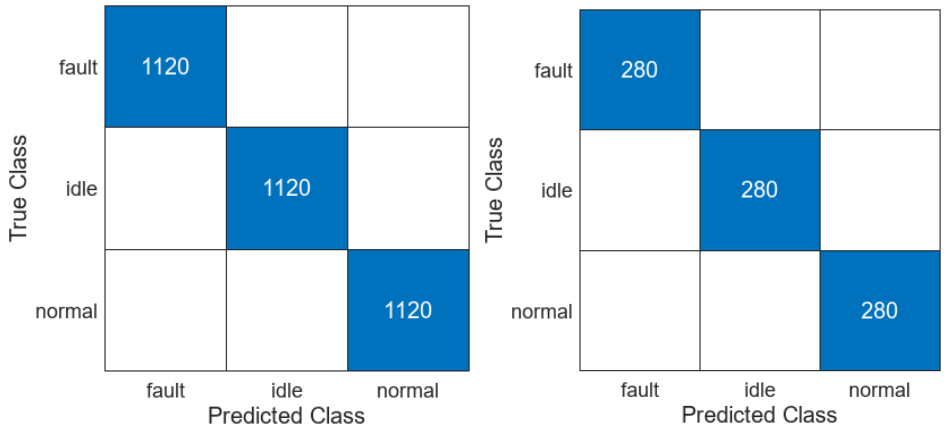
Figure 14. Gyroscope data in the time–frequency domain using mSDFT in 3-axis: top row— Z , mid- dle row— Y , bottom row— X .